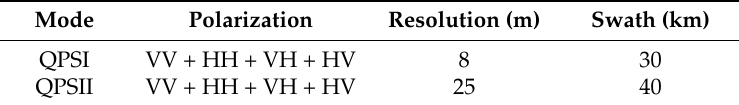
Table 1. Details for QPSI and QPSII modes.